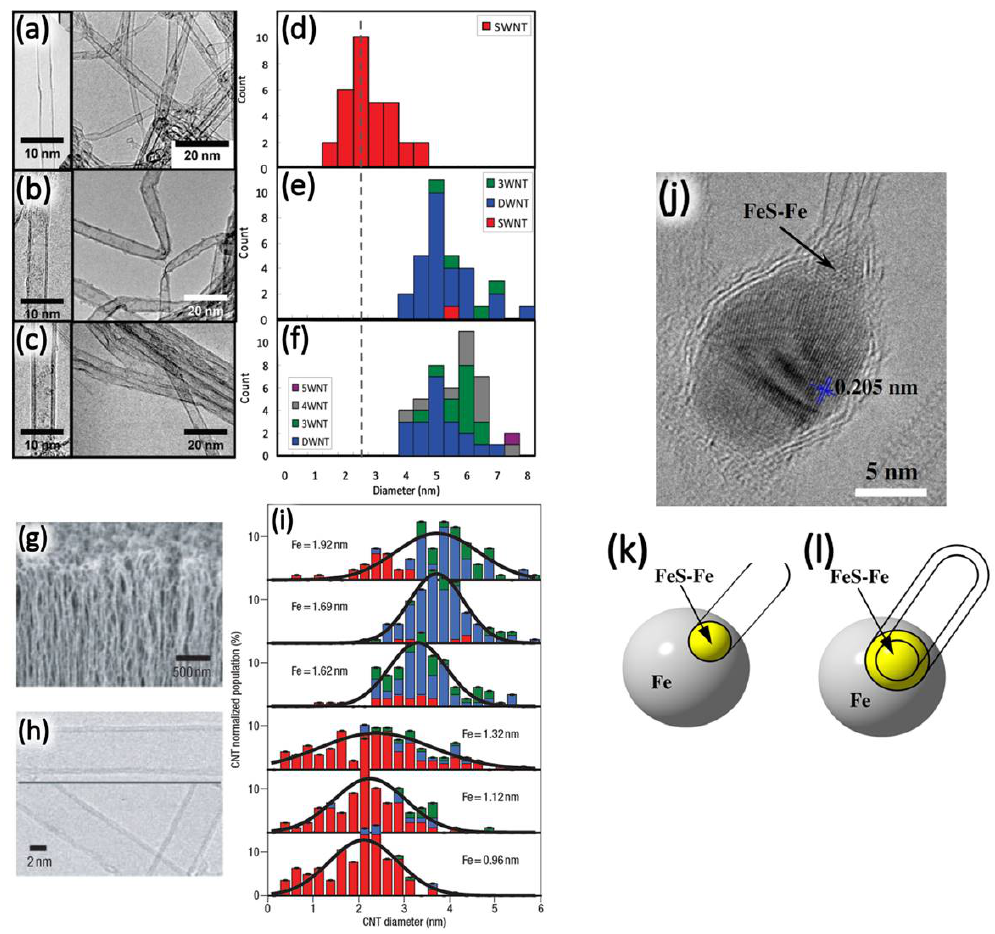
Figure 6. ( a )–( f ) Layer number control of CNTs by introducing a reaction enhancer. Reproduced with permission from [115], Copyright American Chemical Society, 2009. TEM images and histograms show selective growth of SWNTs ( a )–( d ), DWNTs ( b )–( e ) and MWNTs ( c )–( f ), in